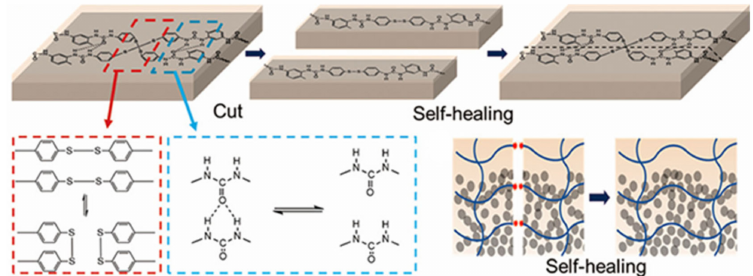
Figure 37. Self-healingprocessofthedevelopedSHP.Reprintedwithpermissionfrom[190]. Copyright(2020) American Chemical